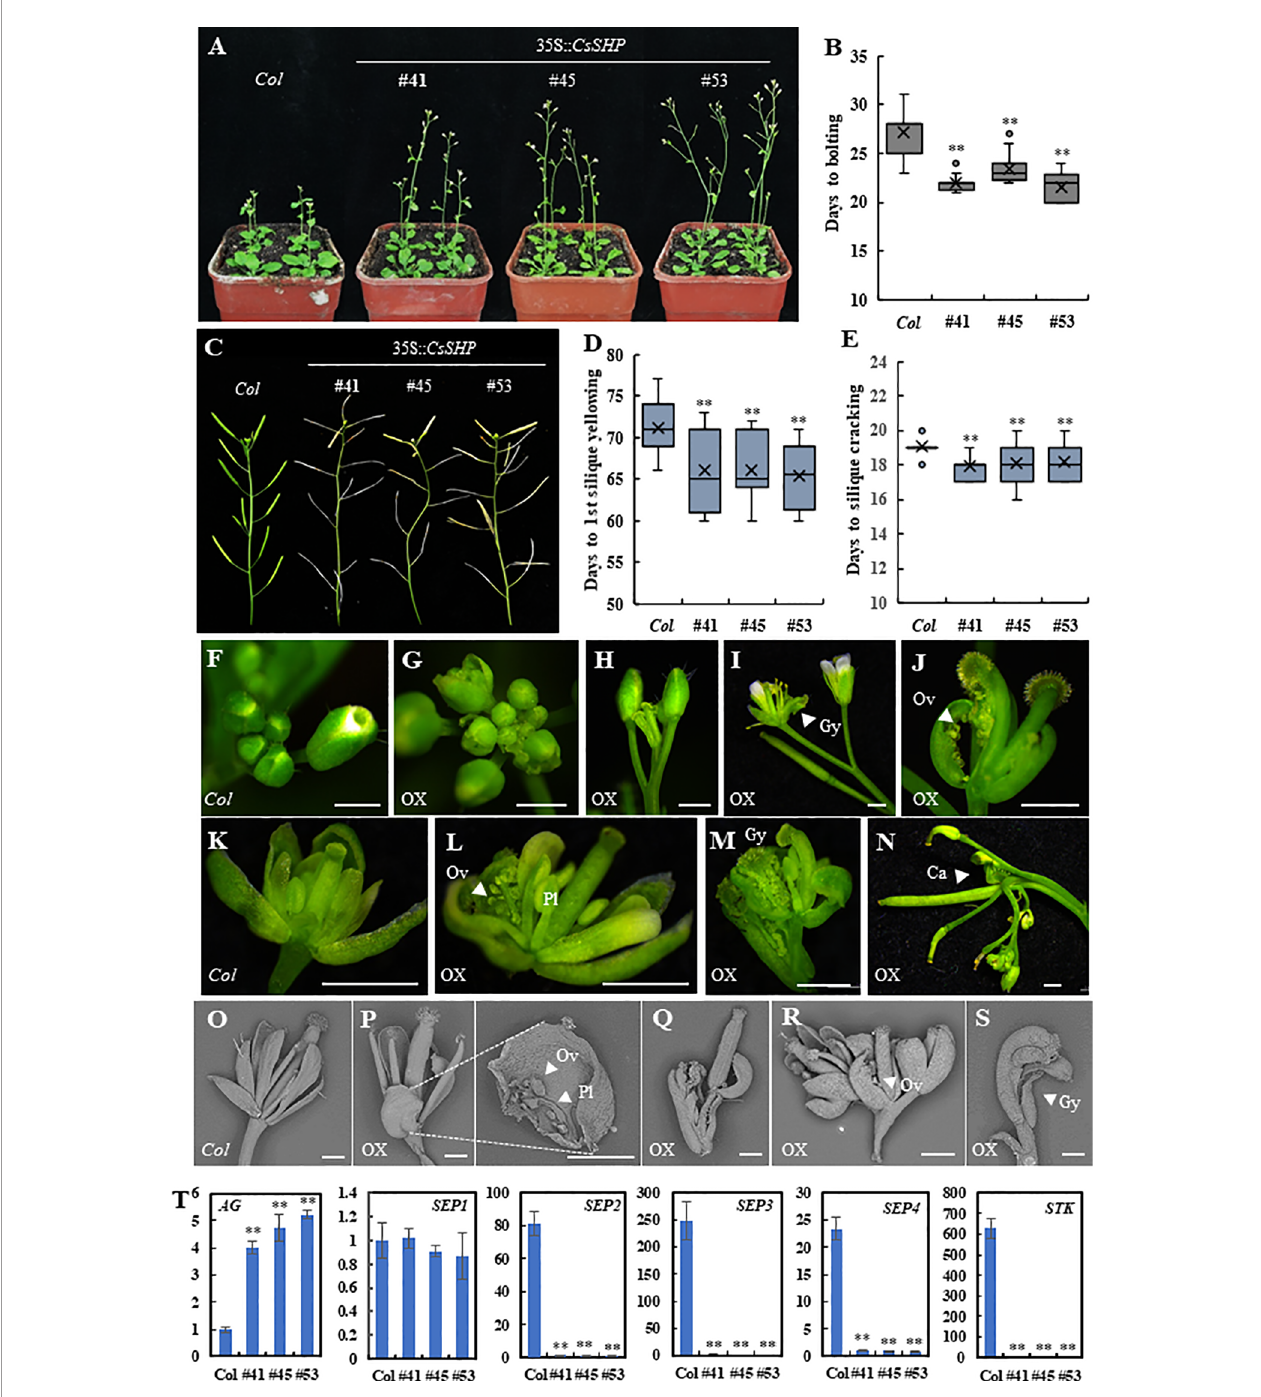
FIGURE 4 | Phenotypic characterization of 35S::CsSHP transgenic plants in Arabidopsis . (A) Representative images of 35S::CsSHP transgenic plants indicated early fl owering in Arabidopsis . (B) Box-plot of the days to bolting in Col and 35S::CsSHP transgenic lines. (C) Overexpression of CsSHP led to precocious phenotype in Arabidopsis. (D, E) Quanti fi cation of the days to yellowing of the 1 st silique (D) and the days from anthesis to silique cracking (E) . The data were the average of 20 plants for each line. (F – S) Overexpression of CsSHP caused defected fl oral organ development in Arabidopsis . (F – N) Anatomic micrographs of fl owers and in fl orescences. Scale bar = 1 mm. (O – S) Scanning electron micrographs of fl owers and siliques. Scale bar = 500 m m. (T) The expression levels of AG , SEP1 , SEP2 , SEP3 , SEP4, and STK in 35S::CsSHP Arabidopsis fl owers. Gy, gynoecium; Ov, ovule; Pl, placenta; Ca, carpel **, t-test (p <